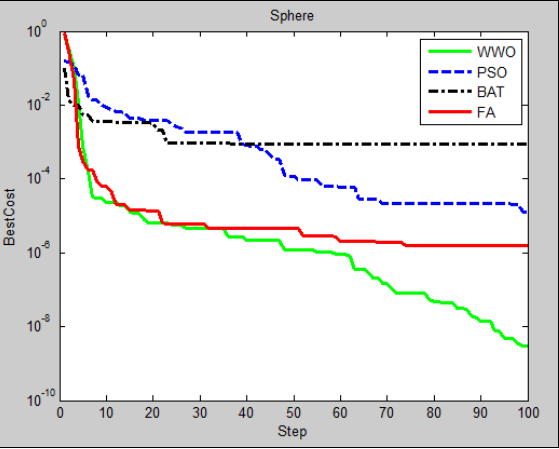
Figure 7. Comparison of convergence and accuracy of water wave